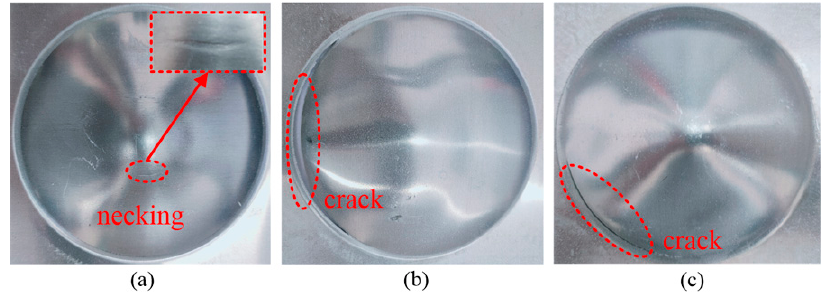
Figure 5. Fracture types at different voltages and temperatures: ( a ) 25 °C, 8 kV; ( b ) 300 °C, 6 kV; ( c ) 400 °C, 6 kV.